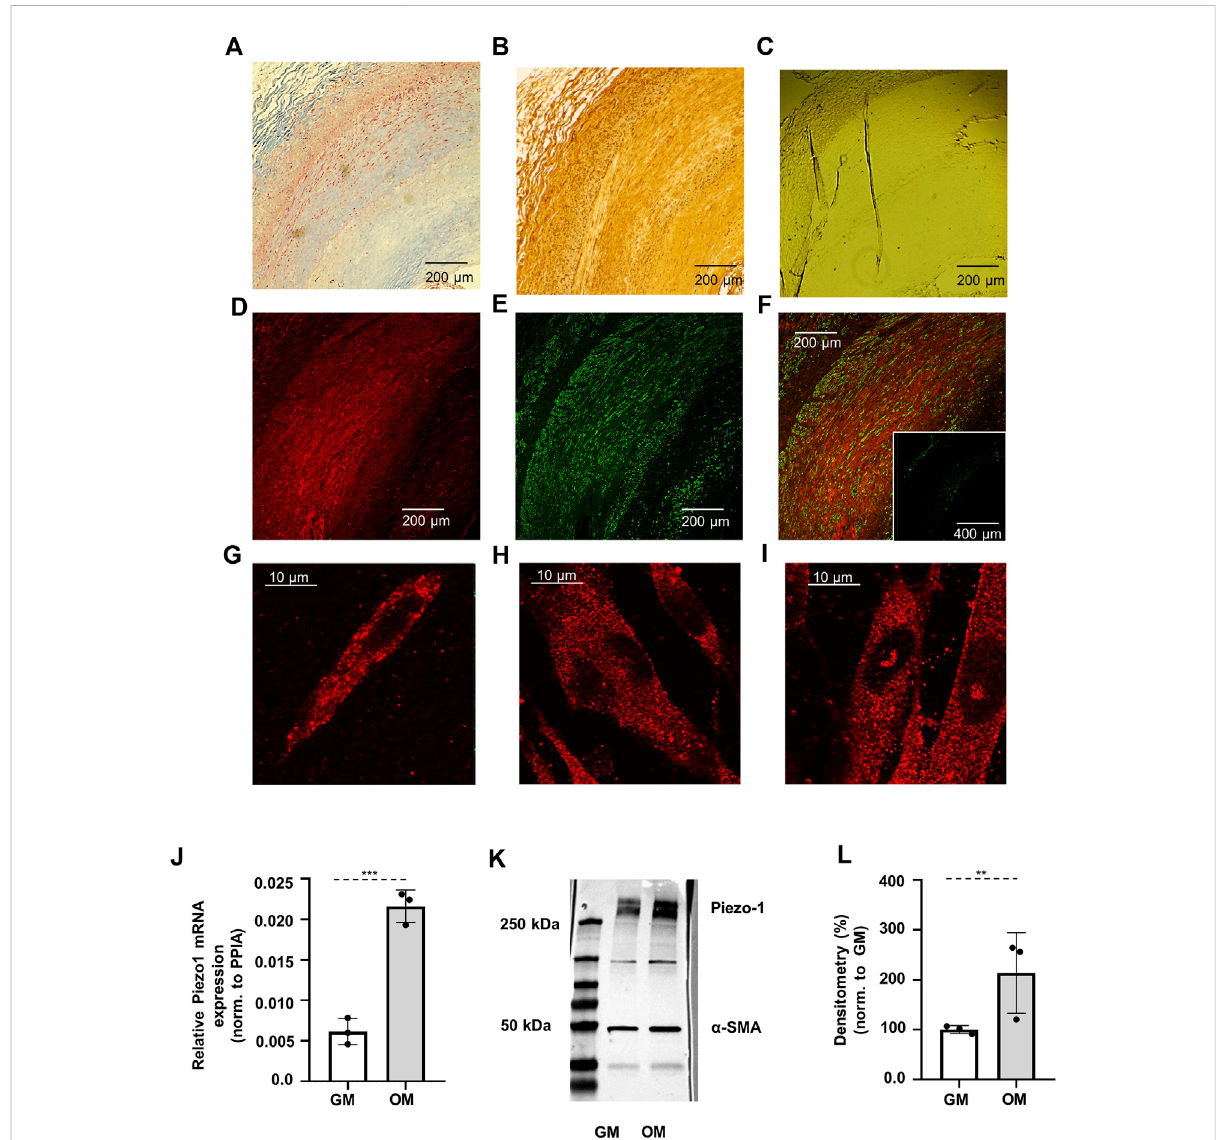
Veri fi cation of the expression of Piezo1 channels. (A) Masson ’ s trichrome staining indicates the smooth muscle layer (red color) in the sections ofhuman internalcarotid artery sample obtained from vascular surgical interventions. (B) DAB staining for Piezo1. The appearance ofbrowncolor in the images demonstrates the presence of Piezo1. (C) Negative control for DAB staining. (D) Localization of Piezo1 in human carotid artery marked with Cy3 (red). (E) Immunostaining of smooth muscle speci fi c alfa-actin ( α SMA) was used to identify smooth muscle cells in the section (green, Alexa488). (F) Merged immuno fl uorescent image from Piezo1 and α SMA. Inset: negative control of immuno fl uorescence labeling. (G) Piezo1expressiononsmoothmusclecellisolatedfrommouseabdominalartery,and (H – I) oncontrolandcalci fi edHAoSMCs,respectively. (J) qPCR analysis ofPiezo1 atmRNA level on HAoSMCs undercontrol (GM) andcalcifying (OM) conditions. (K) Representative Western blotfrom control (GM) and calci fi ed (OM) HAoSMCs labelled for Piezo1 and α SMA as reference. (L) Semi-quantitative estimation of Piezo1 protein expression on